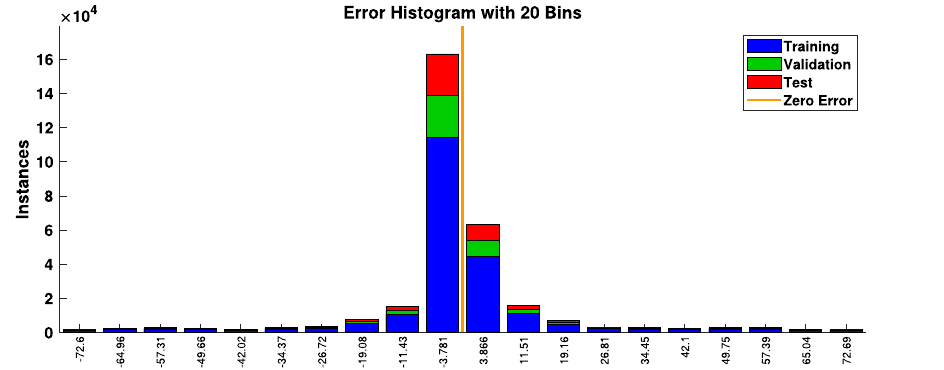
Figure 11. Errors histogram for validation with LMA training function.